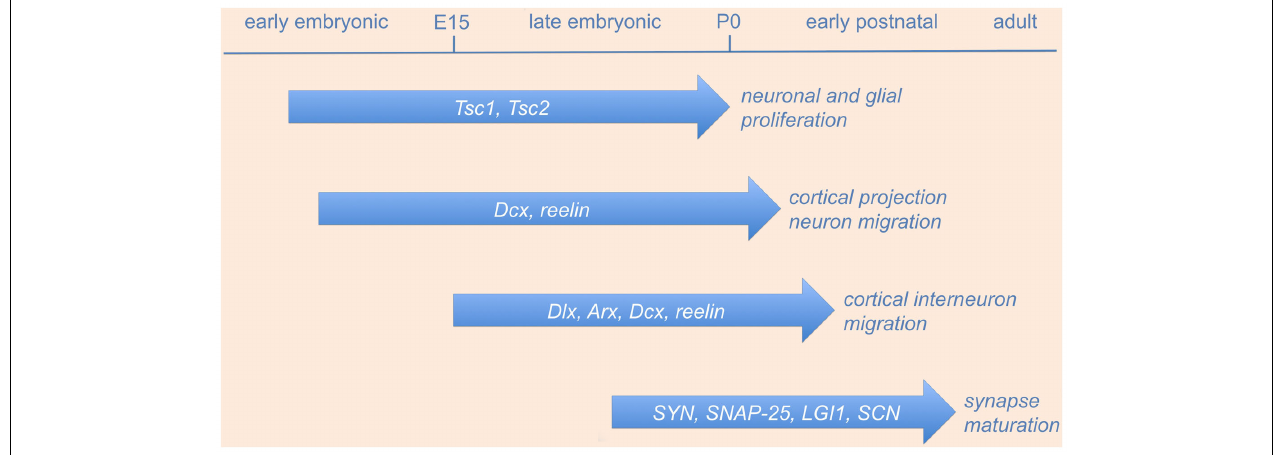
FIGURE 1 | Genes involved in neurodevelopmental causes of epilepsy. The picture shows a schematic time-line of the most significant gene functions involved in neuronal proliferation, neuronal migration, and synaptic